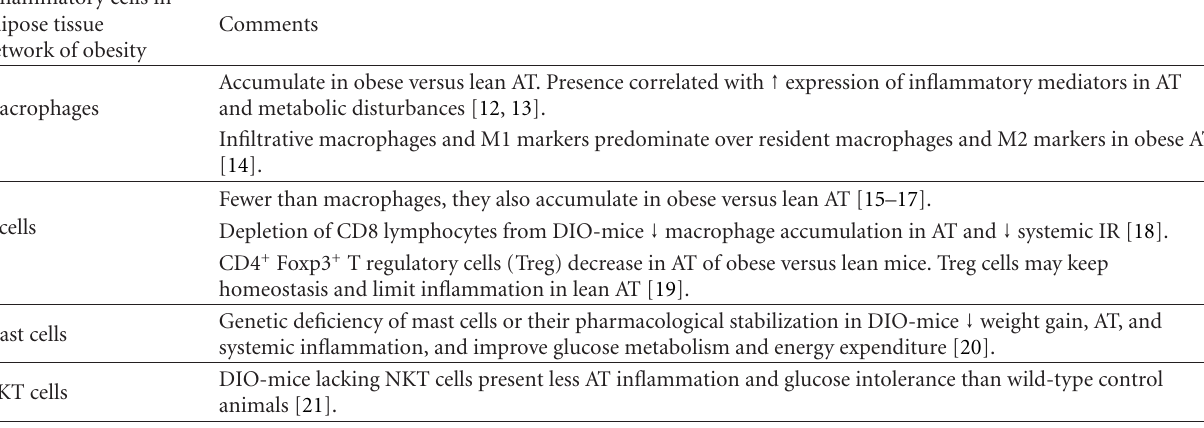
Table 1: Inflammatory cell types in adipose